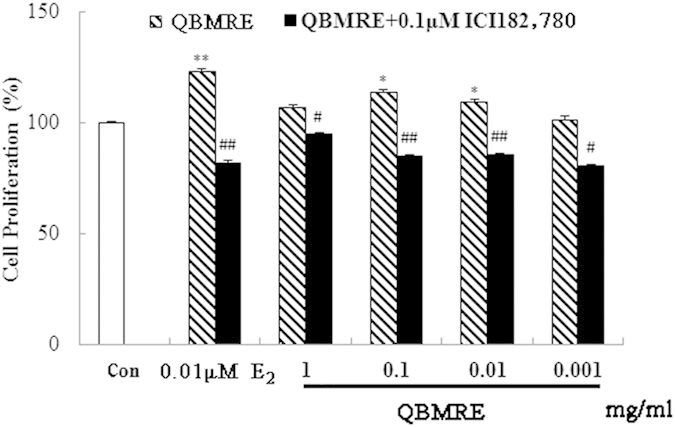
Activity of QiBaoMeiRan formula extract (QBMRE) on proliferation of MCF-7 cells.ICI refers to the estrogen antagonist ICI182, 780 and E2 to 17β-estradiol. Cell proliferation was carried out as described in the Materials and Methods. Results are expressed relative to the growth of cells treated with 1% dimethylsulfoxide (DMSO). Data are the mean ± standard deviation of quadruplicate analyses, expressed relative to that of treatment with 0.1% DMSO. *p < 0.05, **p < 0.01 compared to DMSO; #p < 0.05, ##p < 0.01, compared to QBMRE or 0.01 μM E2.